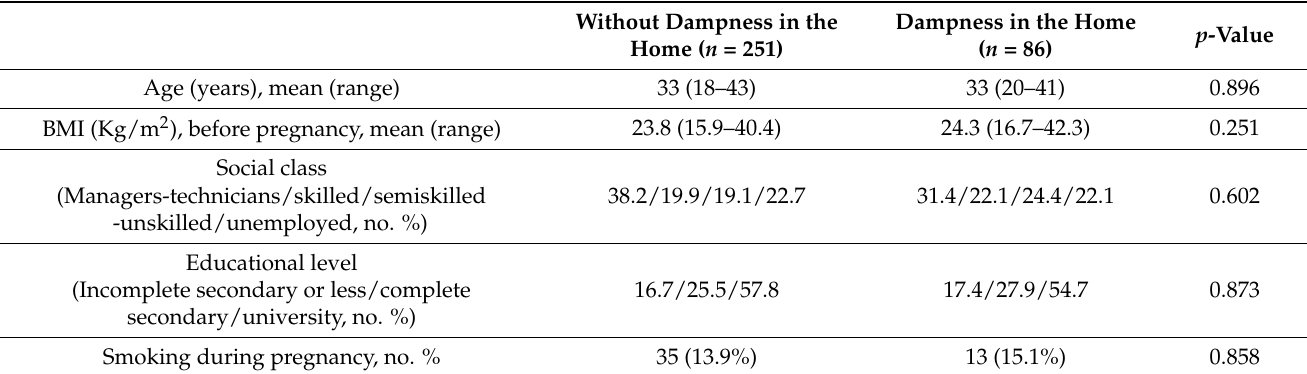
Table 1. Demographic characteristics of mothers included in this study. Without Dampness in the Home ( n = 251)